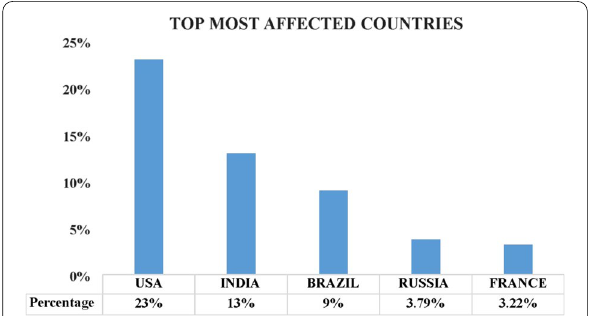
Fig. 2 Graphical representation of topmost affected countries worldwide till December 20, 2020 (WHO dashboard report covid19. who.int)